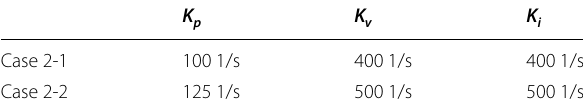
Table 6 Feedback loop gain for control method